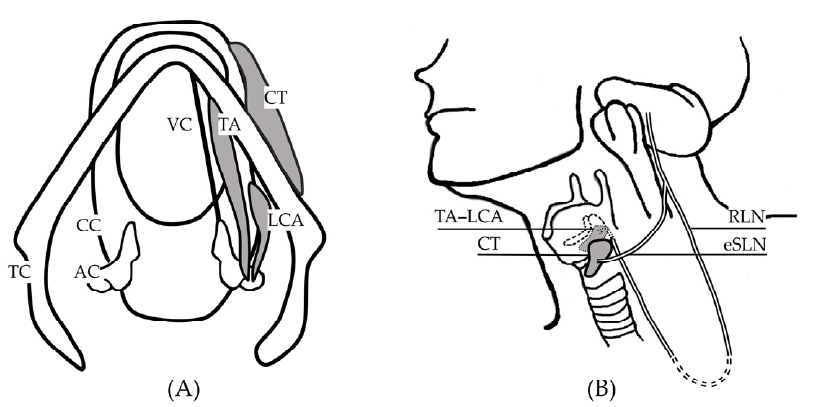
Figure 1. Schematic diagrams of ( A ) superior view with laryngeal muscles and ( B ) innervation of laryngeal muscles. TC, thyroid cartilage; CC, cricoid cartilage; AC, arytenoid cartilage; VC, vocal cord; TA, thyroarytenoid muscle; LCA, lateral cricoarytenoid muscle; CT, cricothyroid muscle; RLN, recurrent laryngeal nerve; eSLN, external branch of the superior laryngeal nerve.